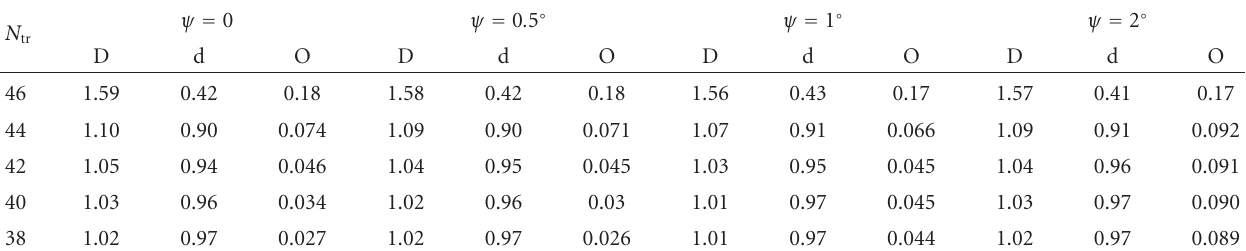
Table 5: Properties of M obtained with Hertzian p . D is the maximum value occurring in the diagonal (all diagonal elements are positive), d is the minimum value occurring in the diagonal, and O is the maximum magnitude occurring away from the diagonal.